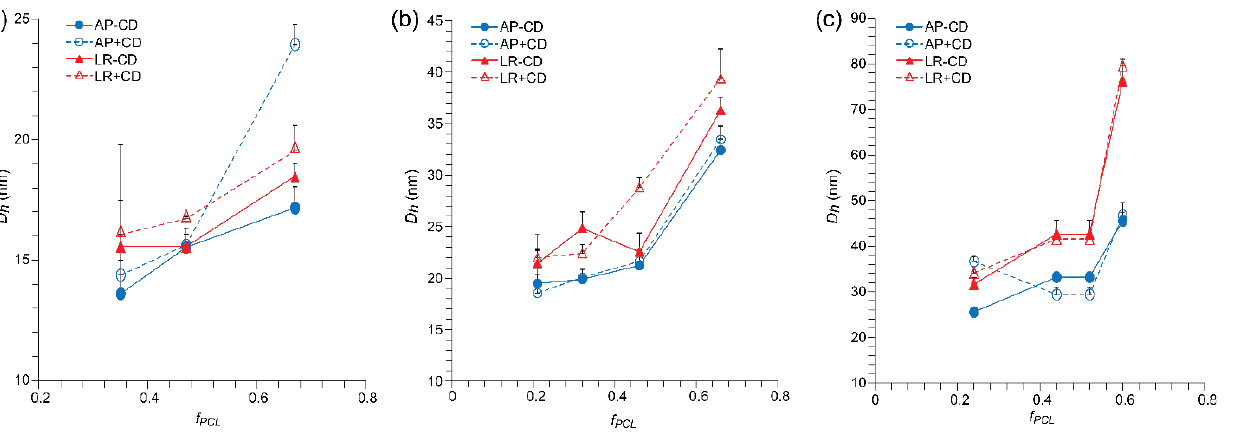
Figure 2. D h versus f PCL as determined from the number PSDs for the ( a ) PEG 2 PCL Y , ( b ) PEG 5 PCL Y , and ( c ) PEG 10 PCL Y micelles as prepared (AP), after lyophilization/reconstitution (LR), and in the absence and presence of β-CD ( − /+CD). All values are reported as the mean + std. dev. ( n = 3).